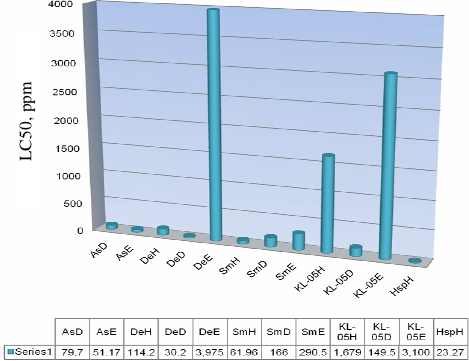
Figure 3. Estimated chronic LC values of 50 the crude extracts of A. suberitoides, D. elegans, S. massa, KL-05 and Haliclona sp.